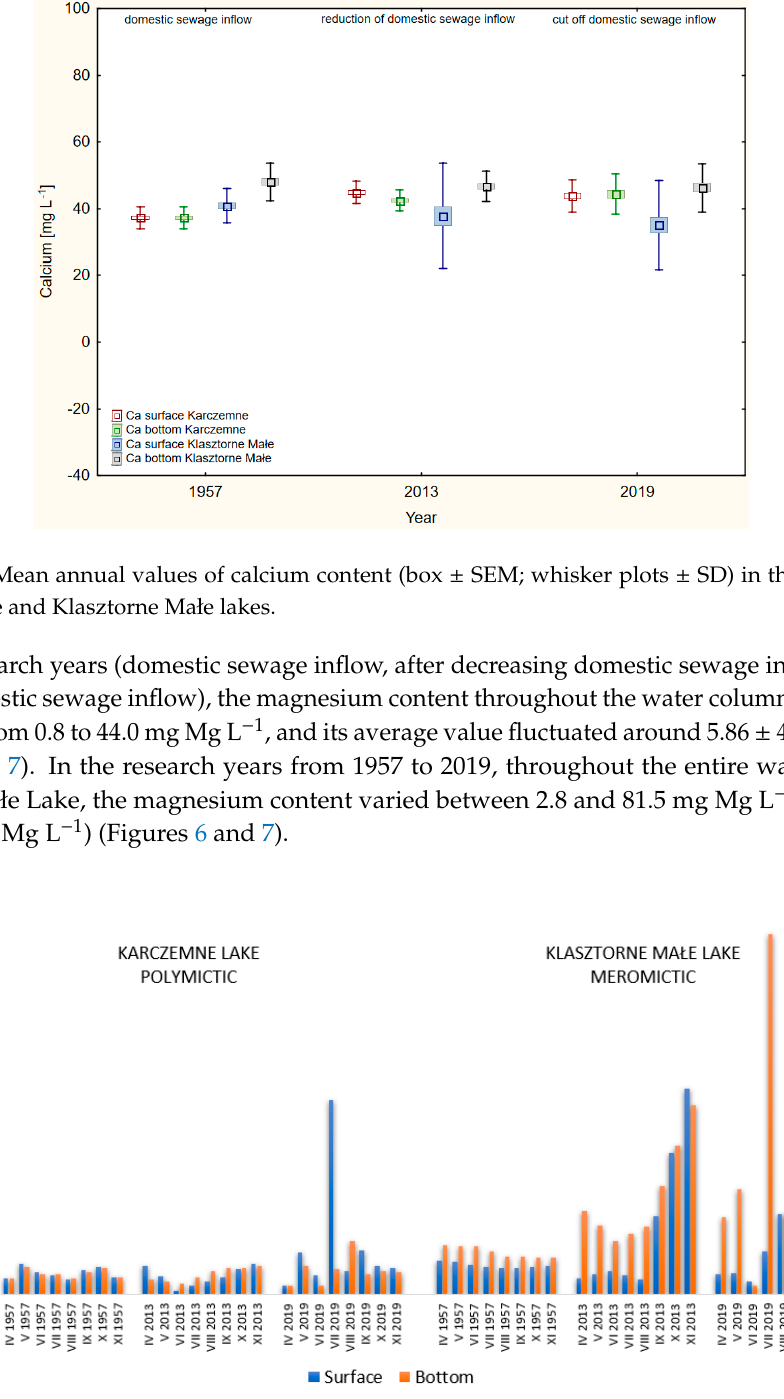
Figure 6. Changes in magnesium content in the water of Karczemne and Klasztorne Małe lakes in selected research years.